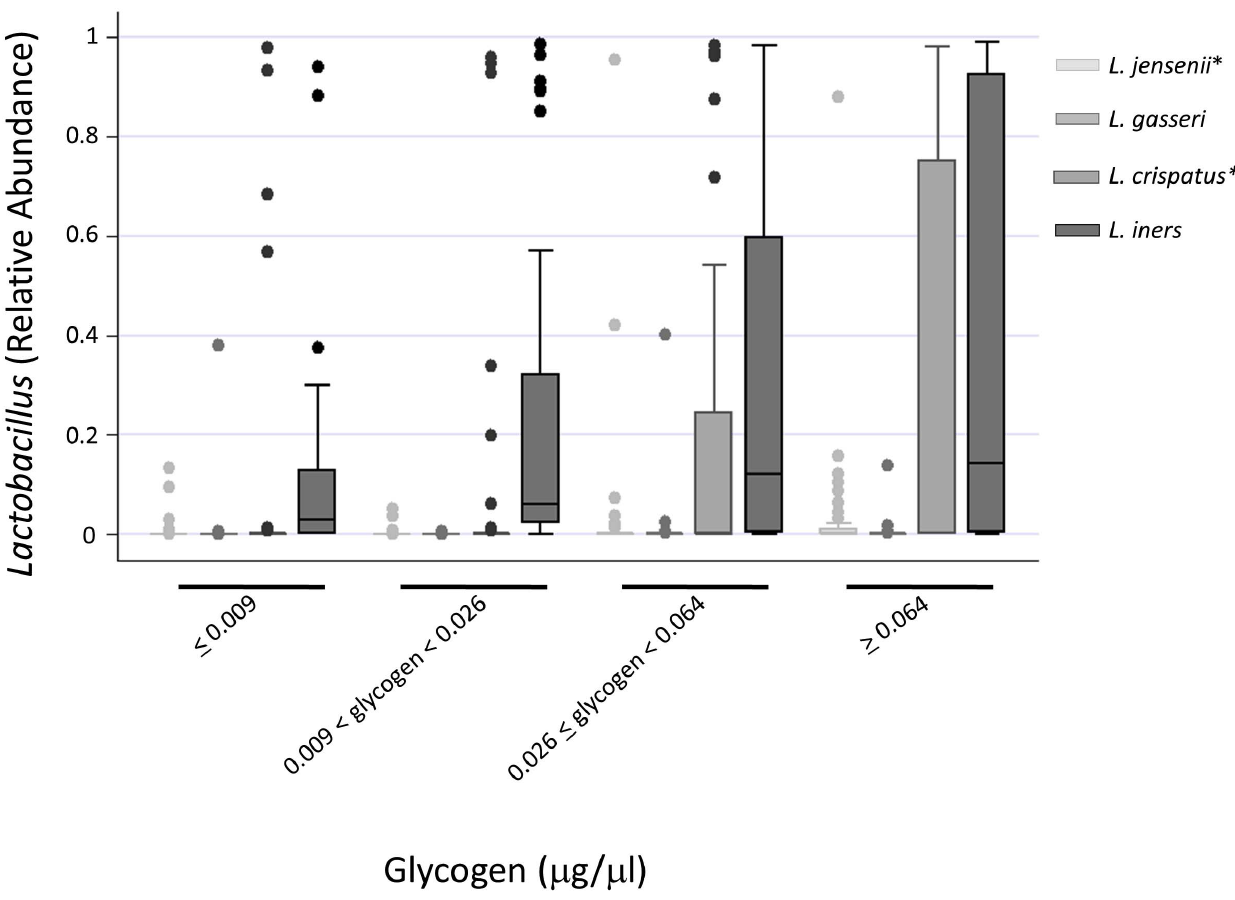
Figure 3. Relative Abundance of Lactobacillus Species by Category of Glycogen Concentration. Free glycogen was analyzed as a binary variable dichotomized about the median and categorically using cutpoints according quartiles of the distribution, as indicated. The distribution of Lactobacillus species relative abundance is summarized by glycogen as a continuous variable by glycogen quartiles. Shaded portions represent interquartile range, horizontal bars represent medians, and whiskers represent 95% confidence intervals. *p , 0.05 using extension of the Kruskal- Wallis test with adjustment for clustering among repeated measurements.